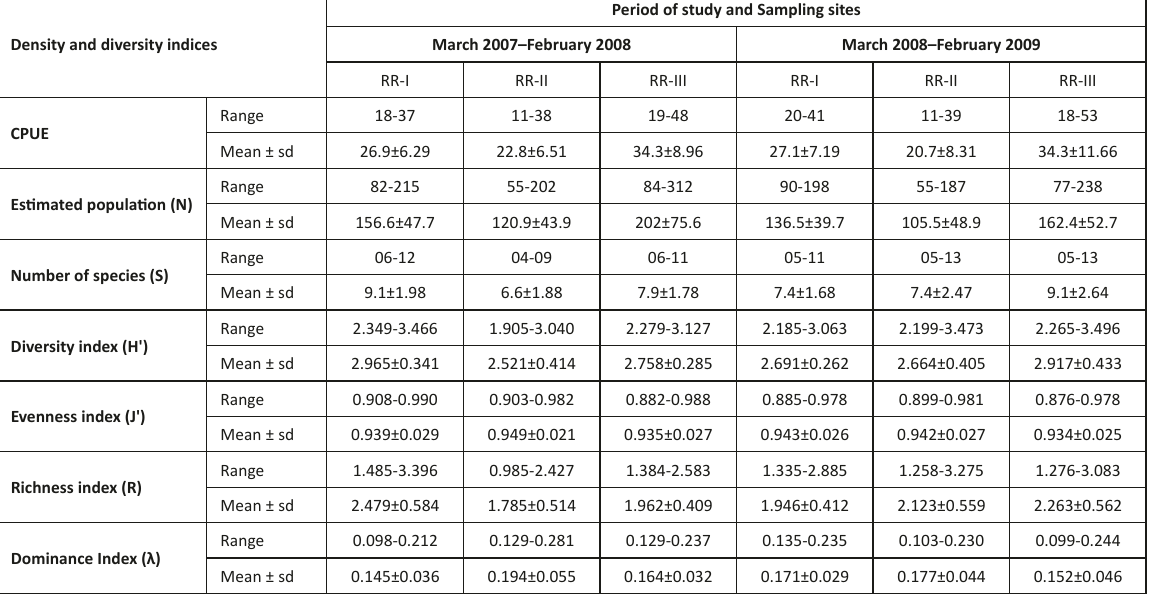
Density and diversity indices